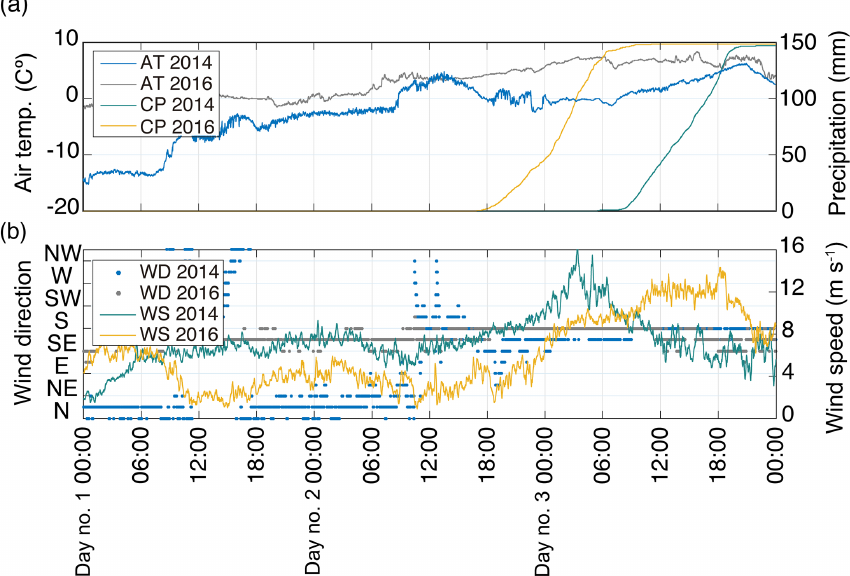
Figure 4. Three-day time series of weather data measured by WS1 at 2020ma.s.l. (Fig. 1) for the events of 2014 and 2016 (Table 1). The day #1 is 11 March 2014 for the 2014 events and 12 February 2016 for the 2016 events. (a) Time series of the mean air temperature (AT) and cumulative precipitation (CP). (b) Mean wind direction (WD) and wind speed (WS). Weather data from WS1 were not available on 5 March